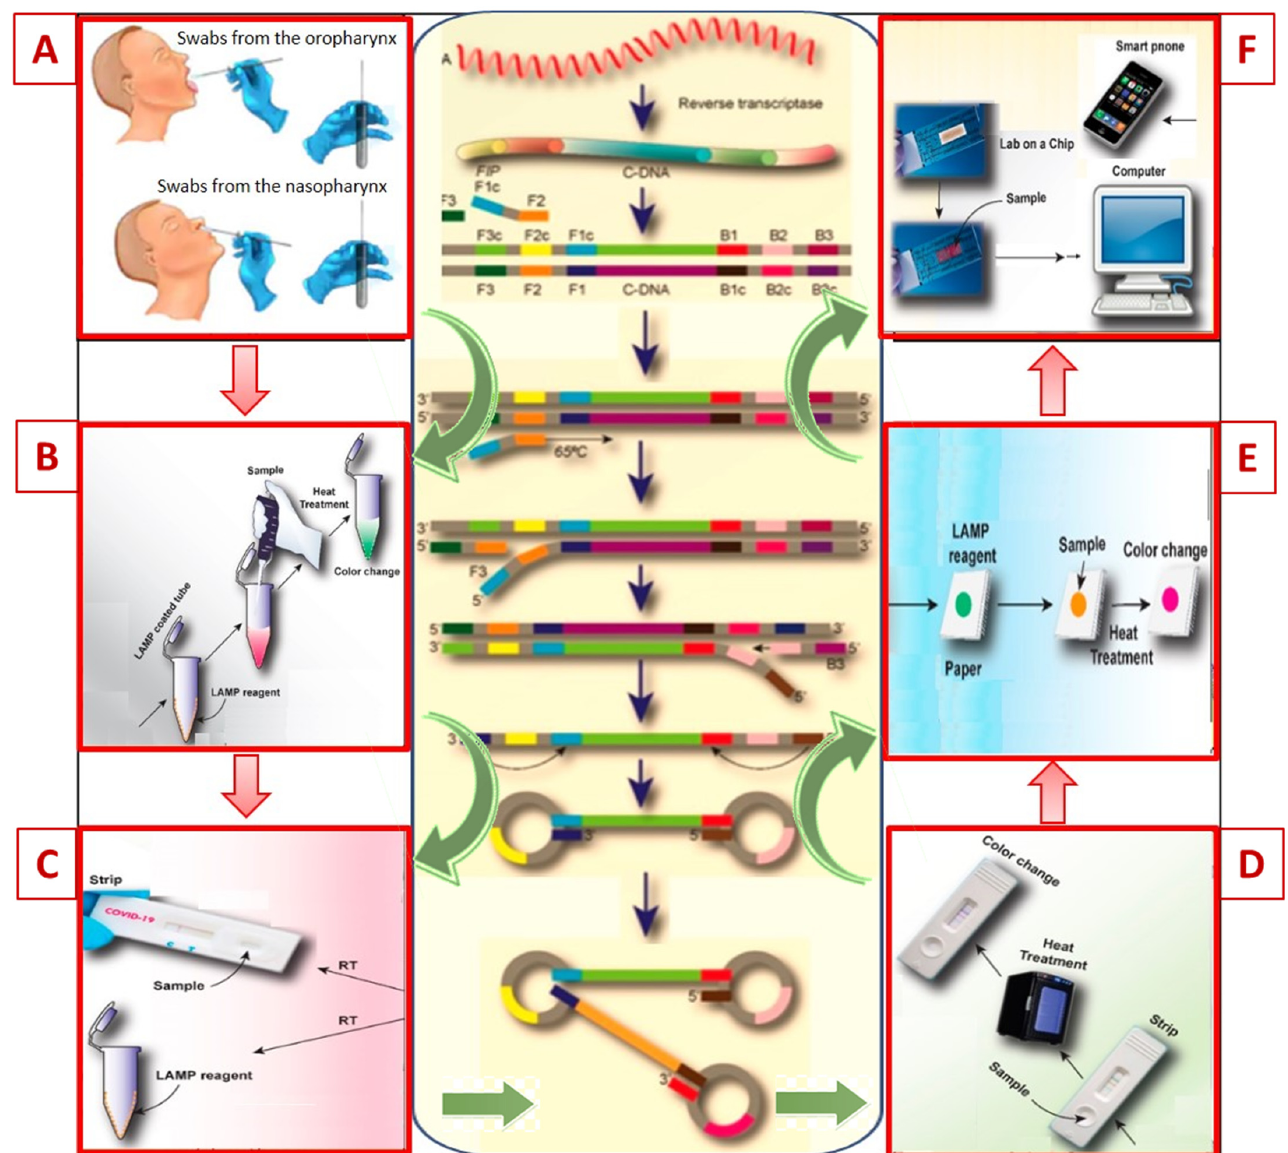
Figure 3. Schematic representation of the amplification sequence for loop mediated isothermal amplification by reverse transcription (RT-LAMP) and future prospects of this technology for the diagnosis of COVID-19. ( A )—for diagnostic COVID-19, samples can be collected by a nasopharyngeal and oropharyngeal swab or sputum; ( B , C )—the samples mixed with the LAMP reagents at 60–65 ◦ C for 30 min to complete the amplification; ( D , E )—visual assessment of the LAMP result using the calcein dye colorimetric reaction reduced the study time to less than 30 minutes; ( F )—full automation of LAMP methods is possible with connection to an electronic device (computer or smartphone) for real-time transmission of the